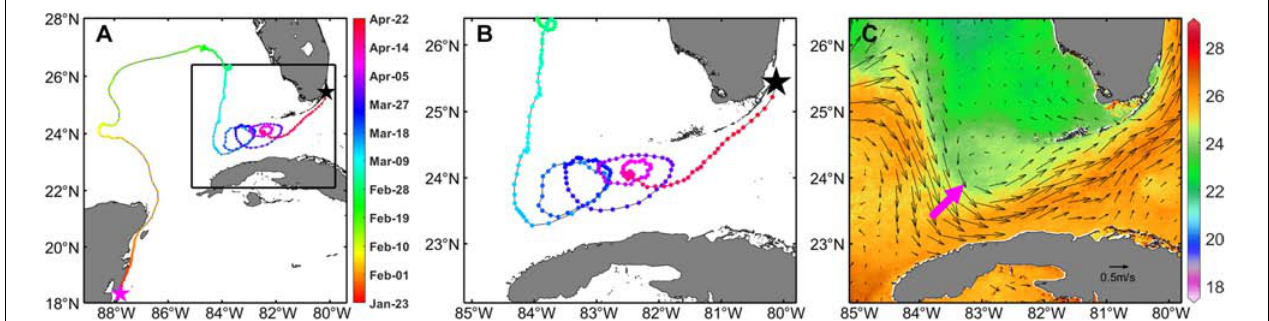
FIGURE 13 | (A) Full trajectory of the drifter no. 62283 from January 23 to April 22, 2007, showing the existence of a CE off the DT. Time is color-coded, and the magenta and black pentagrams represent the start and end points of the drifter, respectively. A region outlined by a black box is enlarged in (B) . (C) Distribution of mean MODIS/A SST (color shadings; unit: ◦ C) from March 11 to April 18, 2007, during which the drifter was entrained within the CE denoted by a thick magenta arrow. The altimetry-based surface currents averaged over the same period are overlaid as black vectors in (C) .